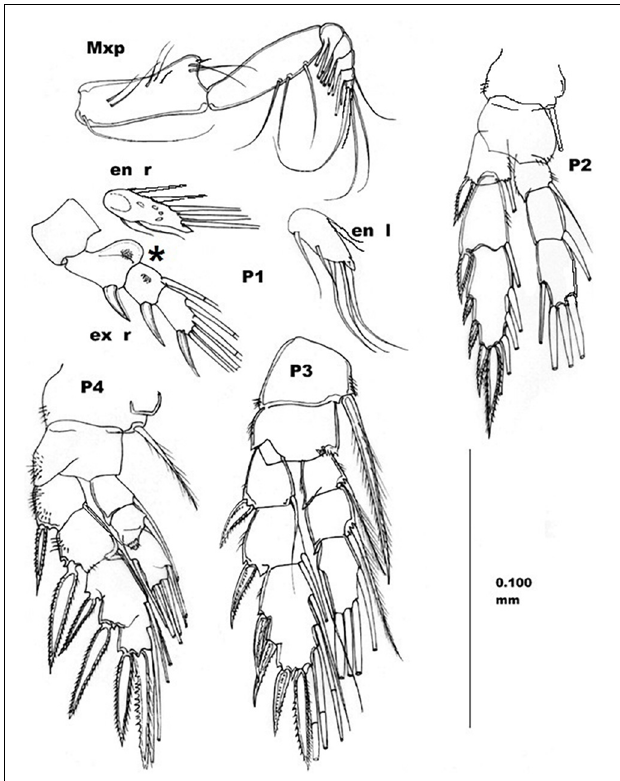
FIGURE 3 | Adult female, Stygocyclopia badinoi n.sp., paratype. Mxp, maxillipede; P1–P4, right swimming legs; en, endopod; ex, exopod; r, right; l, left. Scale bar 0.100 mm. Asterisk indicates the moon shaped body at the level of P1.